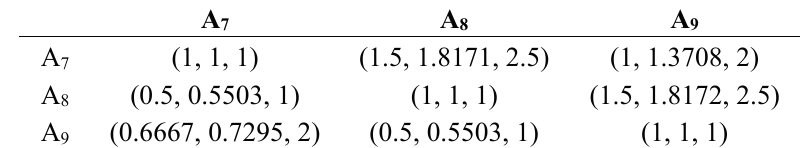
Table 11. The group judgment matrix of the attributes within the “performance”